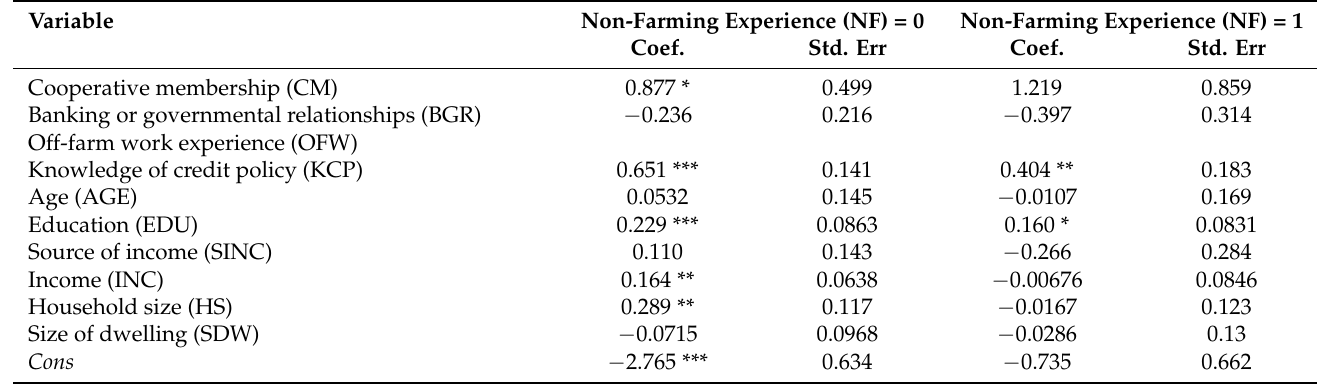
Table 6. Heterogeneity in the loan availability of cooperative membership by NF.